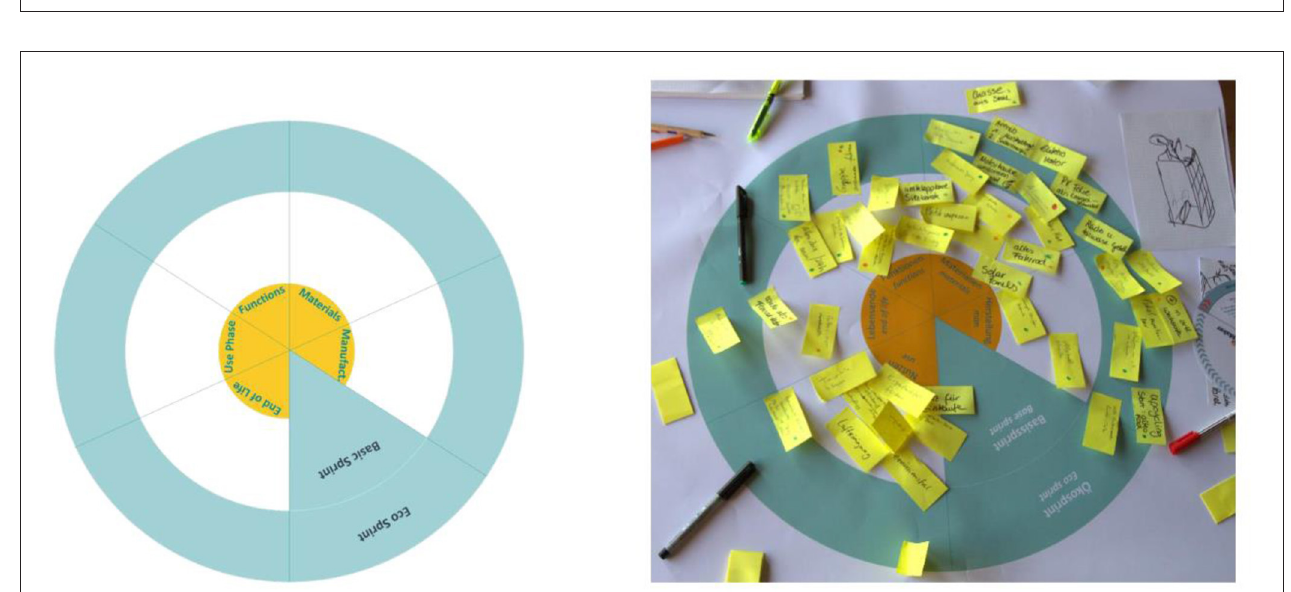
FIGURE 6 | Integration of the ecoMaker Design Sprint into a hackathon format.